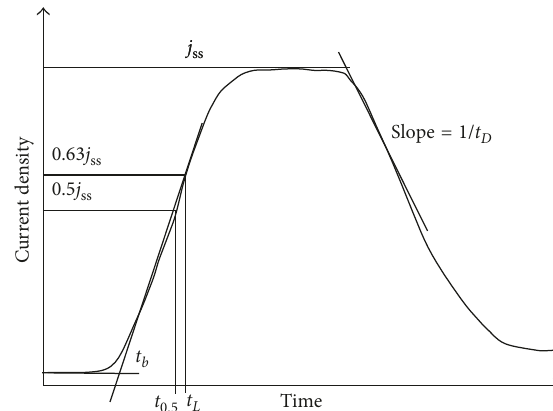
Figure 8: Determination of characteristic times for calculation of diffusion coefficients: time lag t D , breakthrough time t b , half-rise time t 0.5 , and decay time constant t D .